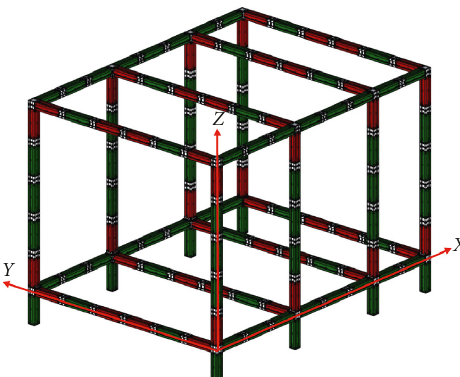
Figure 23: Structural scheme for a diaphanous volume DV (4.8m